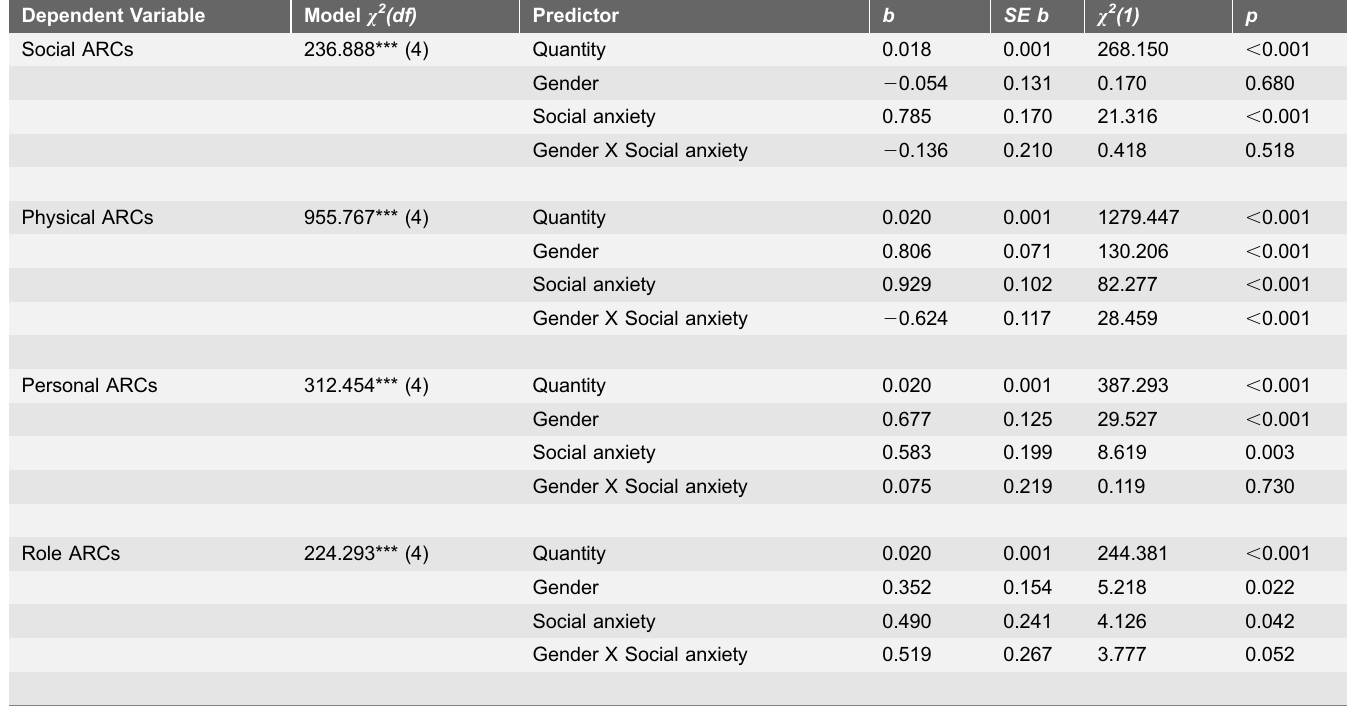
Table 2. Results of poisson